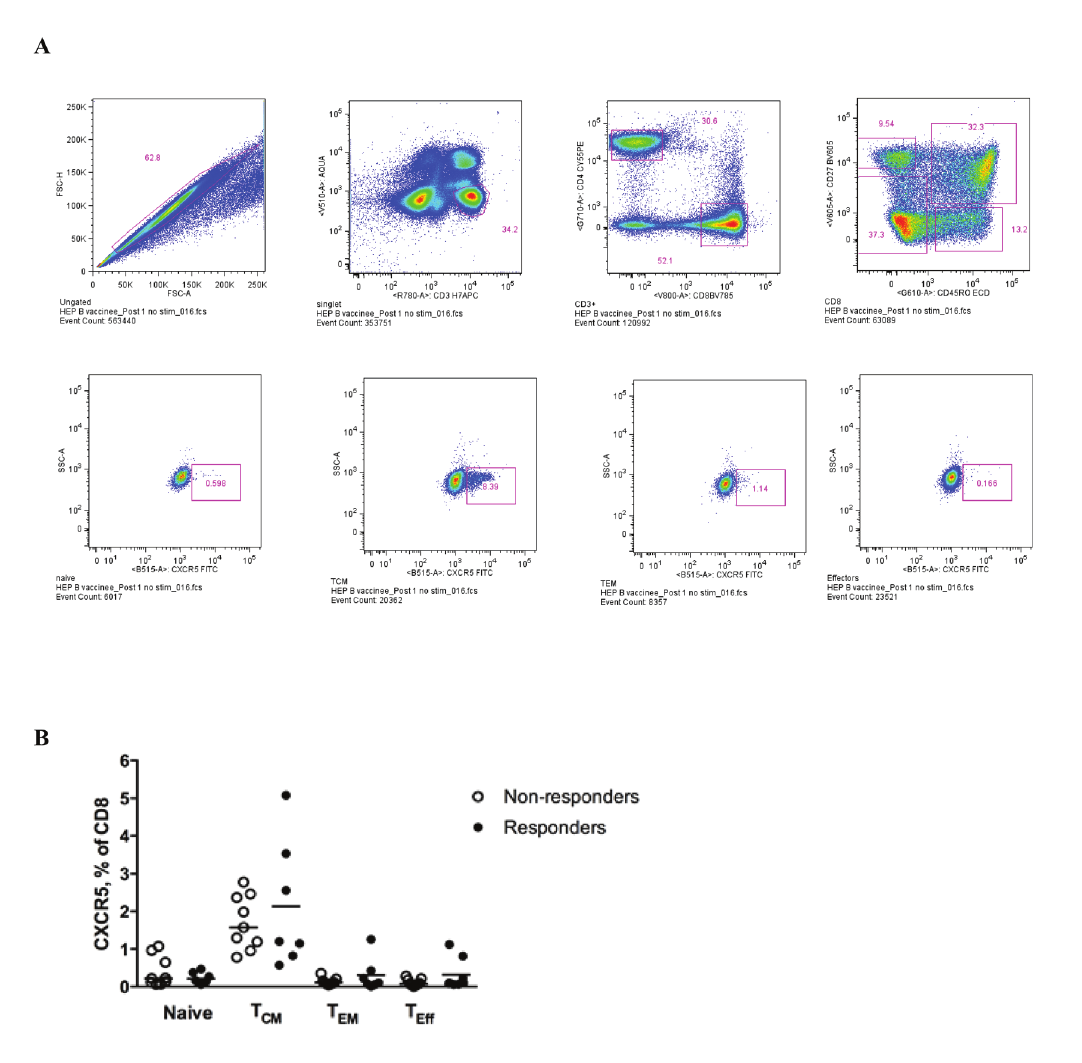
Supplementary Figure 5. (A) Gating scheme for phenotypic analysis of CXCR5 on CD8 populations, (B) Pooled data showing the relative frequencies of CXCR5 high CD8 T-cell populations in non-responders and